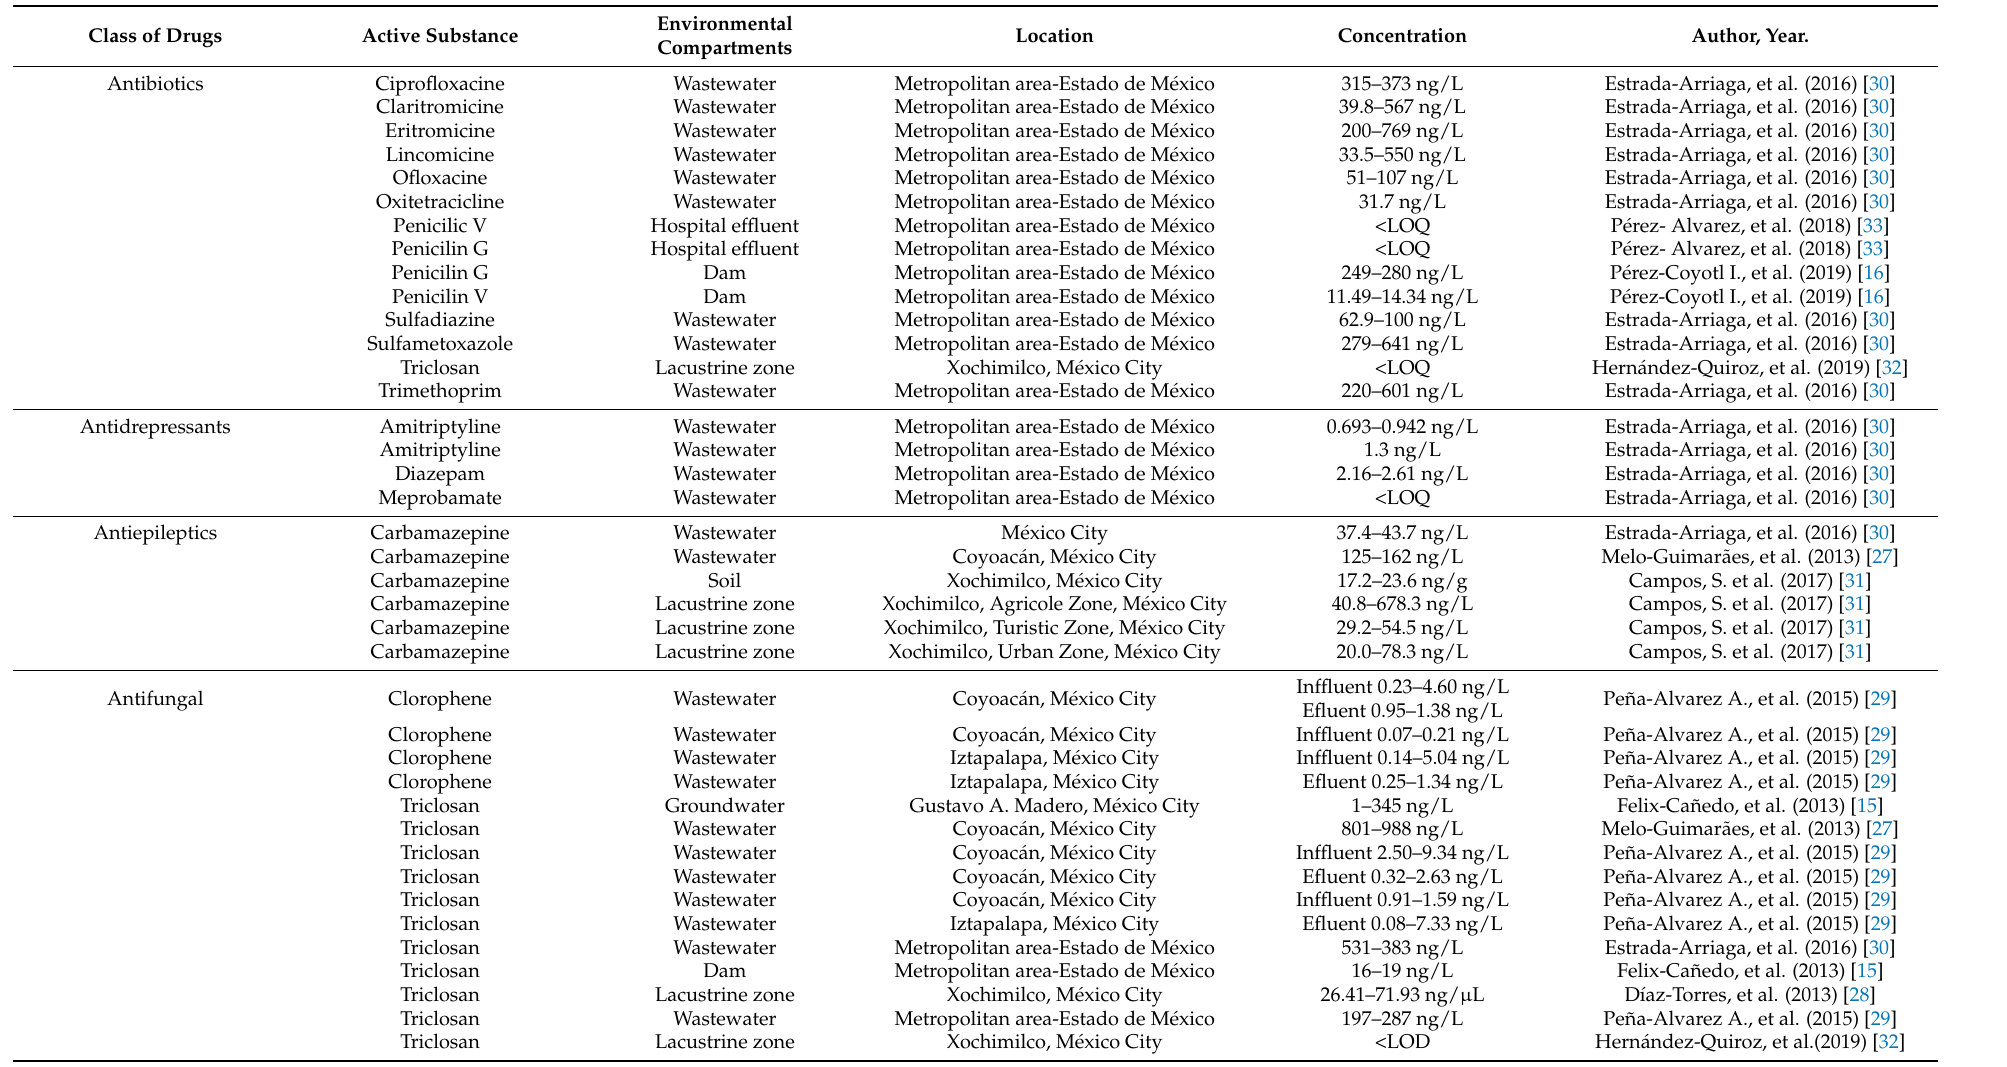
Table A1. Distribution of pharmaceutical residues in adjacent water bodies to Mexico City and the metropolitan area